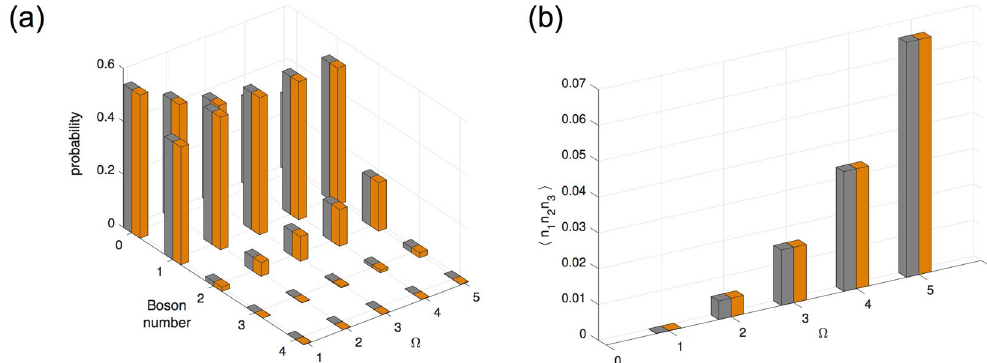
Figure 3. Boson number statistics for site 1 and three-site correlators under a number-conserving transformation in a disordered trimer. Gray bars correspond to the lower sign choice in the parameters listed in Table 1(b), Case 1; and orange bars correspond to the upper sign choice. (a) Boson number statistics as a function of drive strength Ω. (b) Three-site correlator as a function of drive strength. Although the NESS changes between the two different sign choices at each drive strength, the number statistics and the correlator remain the same even in the presence of strong disorder.